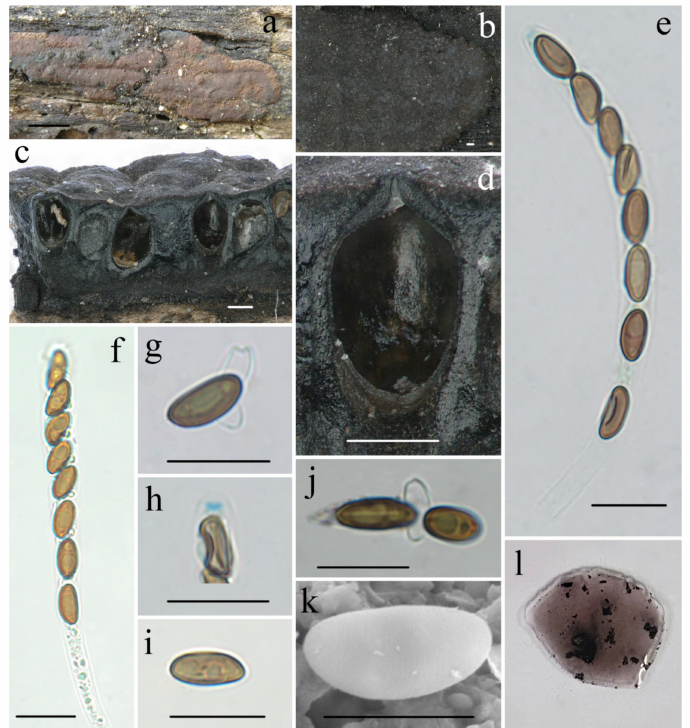
Figure 4. Hypoxylon hainanense (holotype FCATAS 2712). ( a ) Stromata on wood. ( b ) Stromatal surface. ( c , d ) Stroma in vertical section showing the perithecia and tissue below the perithecial layer. ( e ) Ascus in Melzer’s reagent. ( f ) Ascus in water. ( g ) Ascospore in 10% KOH. ( h ) Apical apparatus in Melzer’s reagent. ( i ) Ascospore in water. ( j ) Ascospore in 10% KOH showing germ slit. ( k ) Ascospore under SEM. ( l ) KOH-extractable pigments. Scale bars: ( a ) = 1cm; ( b – d ) = 200 µ m; ( e – j ) = 10 µ m; ( k ) = 5 µ m. MycoBank: MB